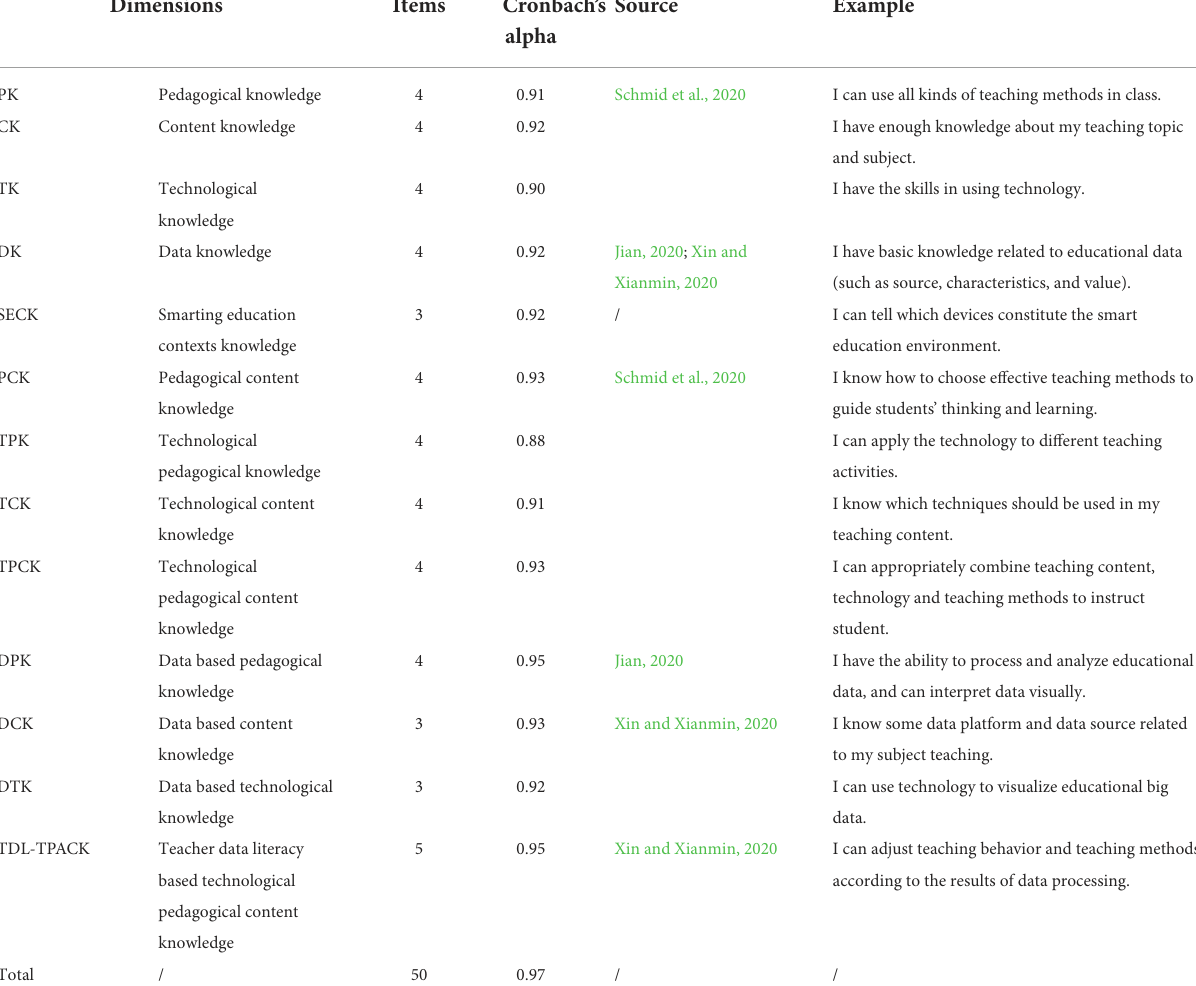
TABLE 3 TDL-TPACK framework for